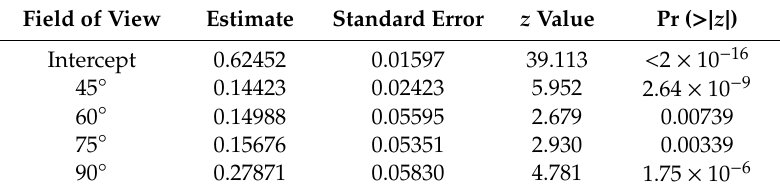
Table 2. The results of the logistic regression analysis concerning the camera field of view as variable. Field of